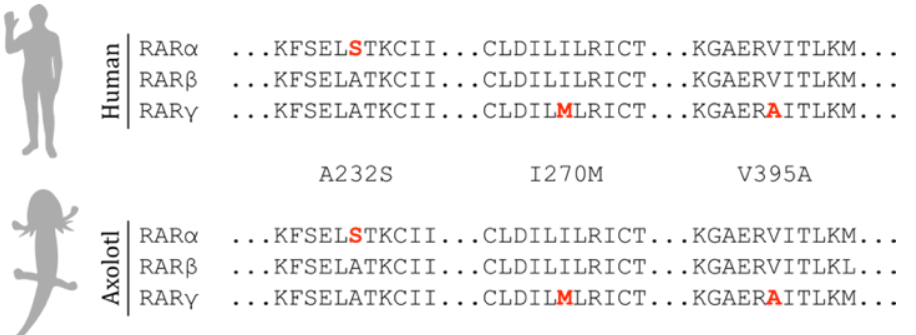
Figure 2. The three retinoic acid receptors (RARα, RARβ, and RARγ) are homologous, as seen in the alignments of select regions of the ligand-binding domain of both human (top) and axolotl (bottom). Three amino acid substitutions, depicted in red, grant binding specificity to the RAR agonists Am580, CD2019, and CD437. The protein sequences were obtained from the EST database hosted at Sal-Site [26].